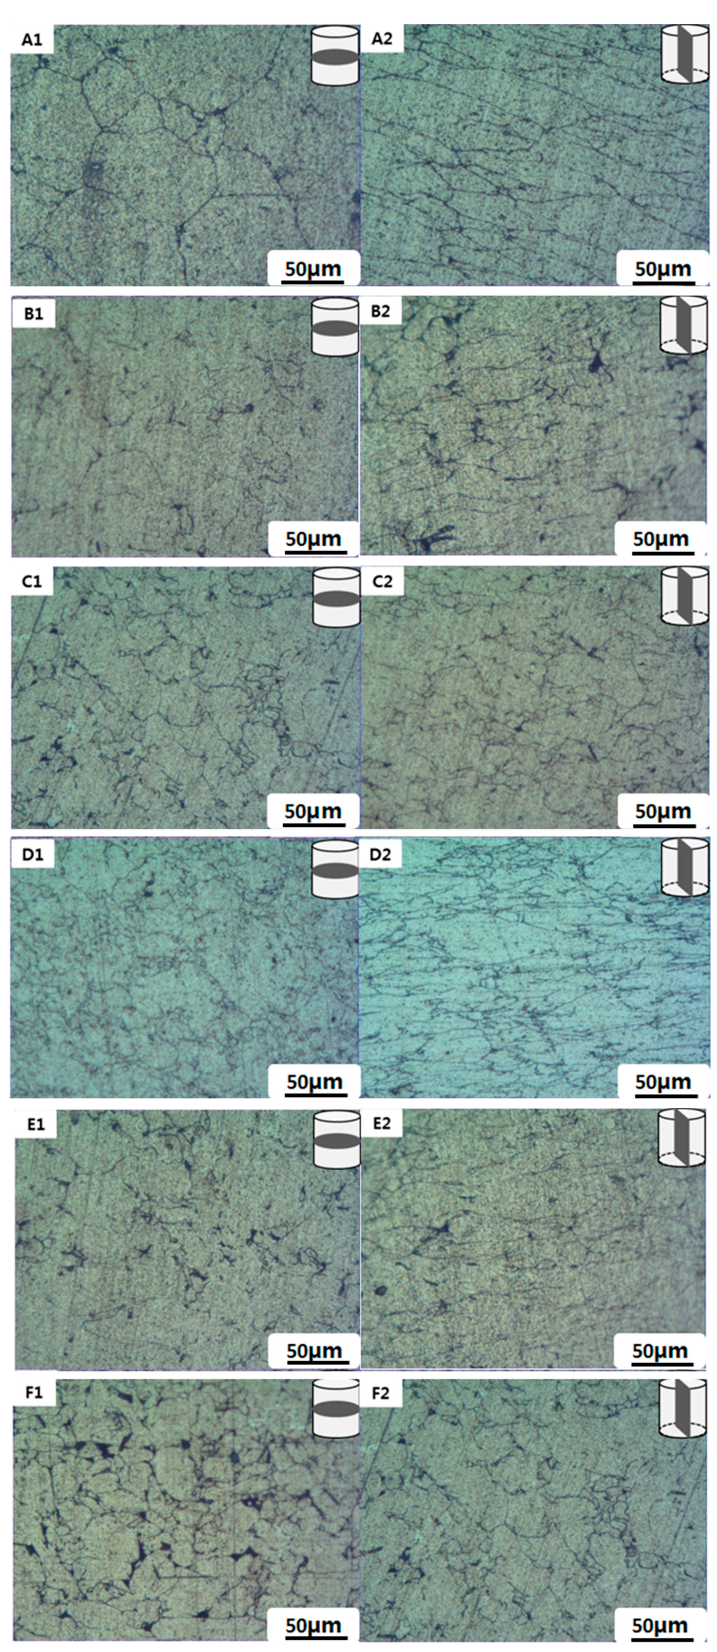
Figure 10. Microstructure for variation of MWCNTs volume fraction after open-die forging ( Al , A2 : Microstructure for variation of MWCNTs volume fraction after open-die forging Al6061; B1 , B2 : 1 vol %; C1 , C2 : 3 vol %; D1 , D2 : 5 vol %; E1 , E2 : 7 vol %; F1 , F2 : 10 vol %). (( Al , A2 ) Al6061; ( B1 , B2 ) 1 vol %; ( C1 , C2 ) 3 vol %; ( D1 , D2 ) 5 vol %; ( E1 , E2 ) 7 vol %; ( F1 , F2 ) 10 vol